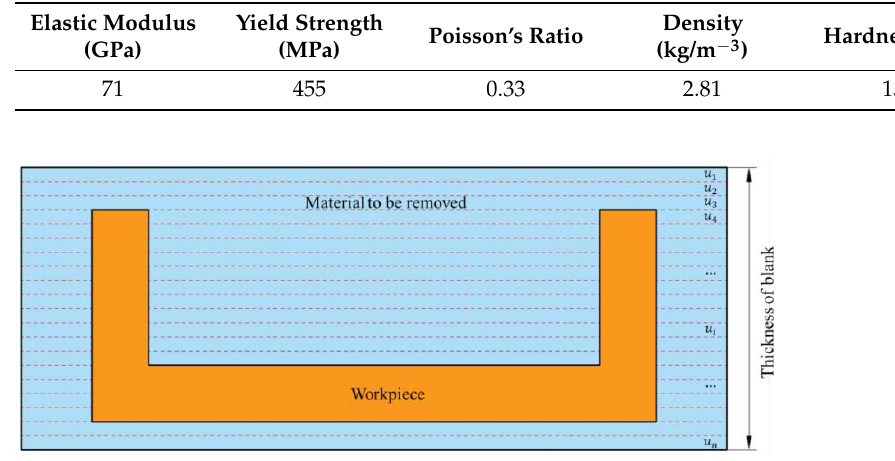
Figure 3. Schematic of material layer-by-layer milling.